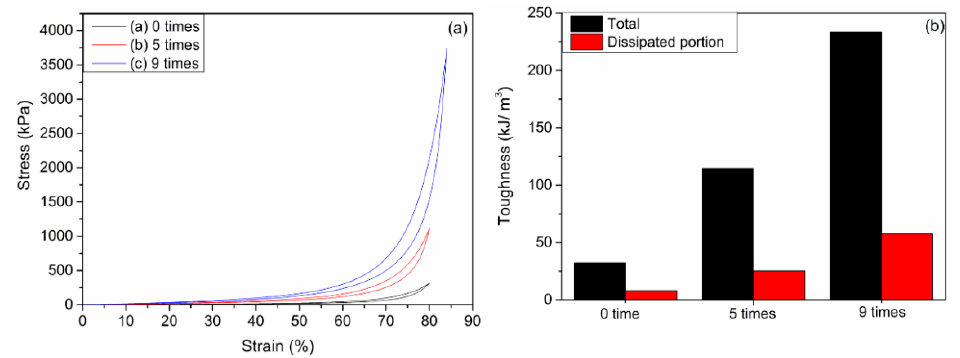
Figure 7. ( a ) Loading-unloading stress-strain curves and ( b ) the total toughness and dissipated toughness of the CDs 3.0 / HA 0.6 / PVA DN hydrogel after 0, 5, and 9 freezing-thawing cycles at a strain of 80%. The compression velocity was fixed at 10 mm min − 1 .